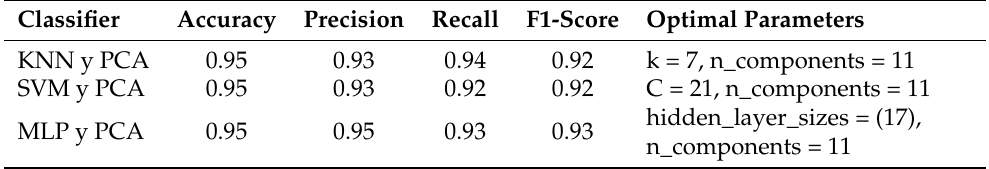
Table 4. Optimal parameters and precision results for each of the